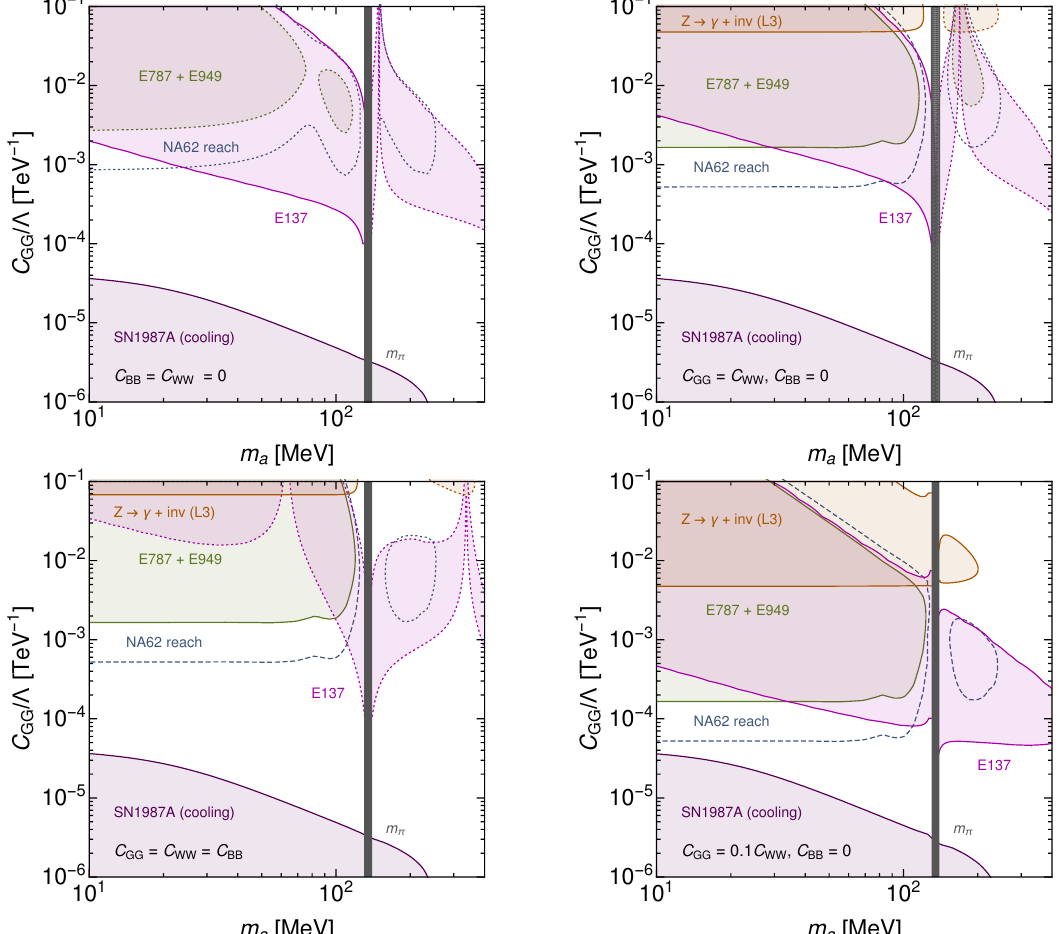
Figure 7 . Same as (cid:12)gure 4 but including the signal region 2 of NA62. Starting from the top left (clockwise) we focus on dominant C GG , then C GG = C WW followed by C GG = 0 : 1 C WW and lastly C GG = C WW = C BB . Constraints that are a(cid:11)ected by hadronic uncertainties (most importantly the ALP mixing with (cid:17) and (cid:17) 0 ) are shown with dotted lines. This a(cid:11)ects in particular signal region 2 through the e(cid:11)ective photon coupling, except in the bottom-right panel, where the a { (cid:17) and a { (cid:17) 0 mixing contributions to the photon coupling are